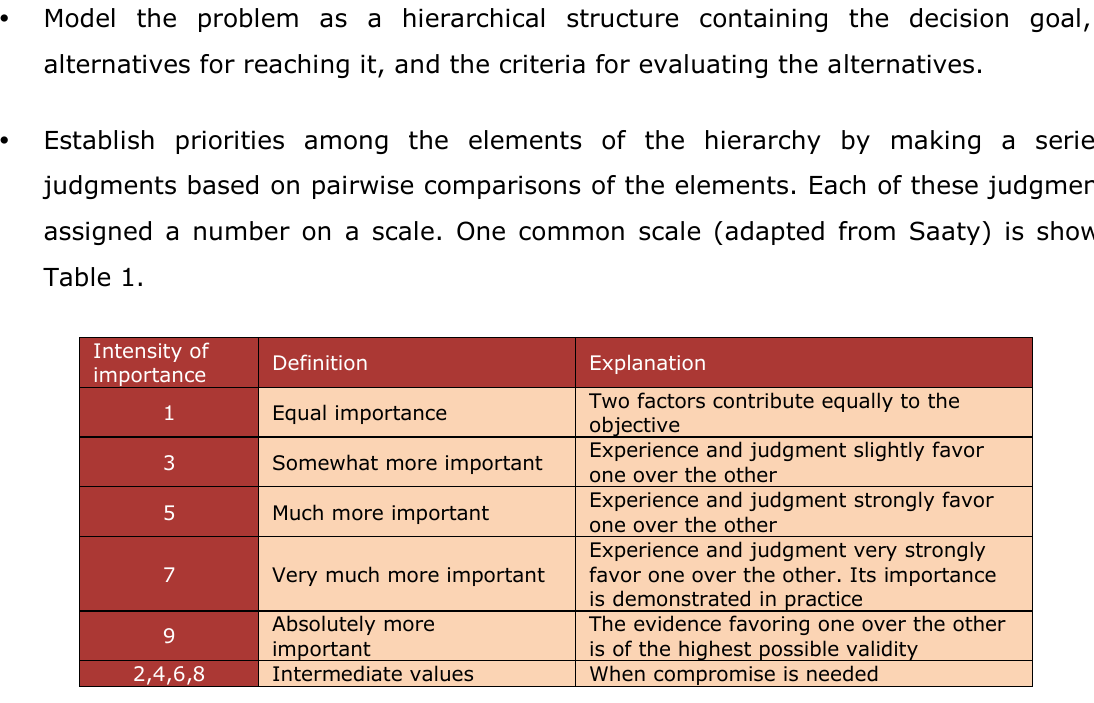
Table 1. Manufacturing vs.